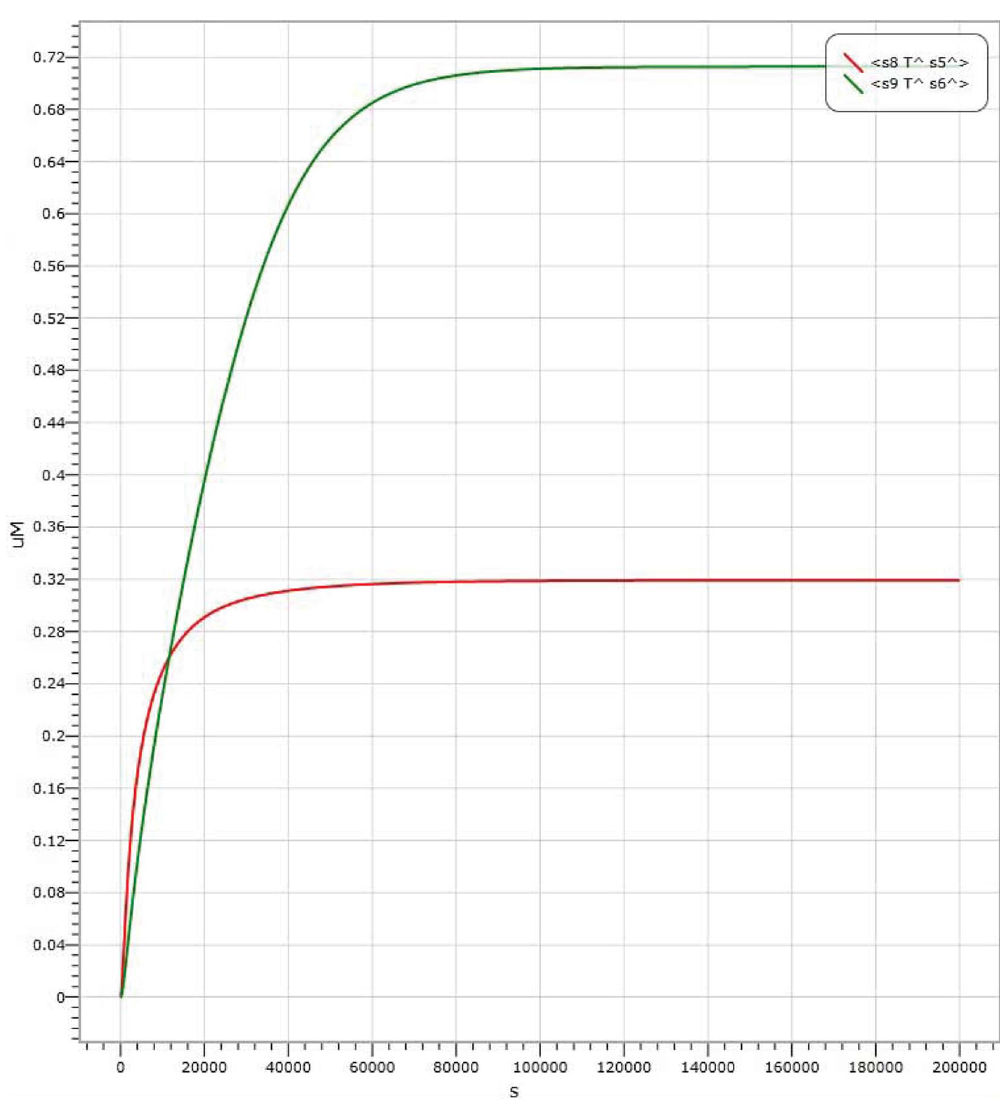
Figure 9. Visual DSD simulations of XOR logic gate with input signal ‘‘00’’.